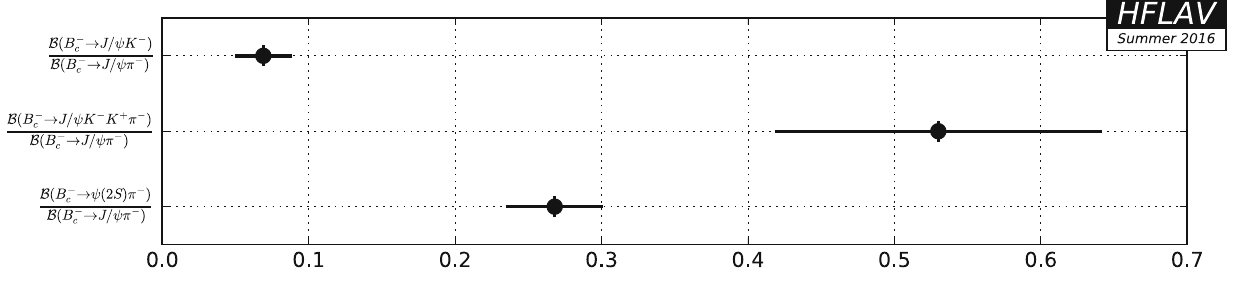
Fig. 167 Summary of the averages from Table 203 Table 206 Decays to B 0 s meson [ 10 − 3 ]